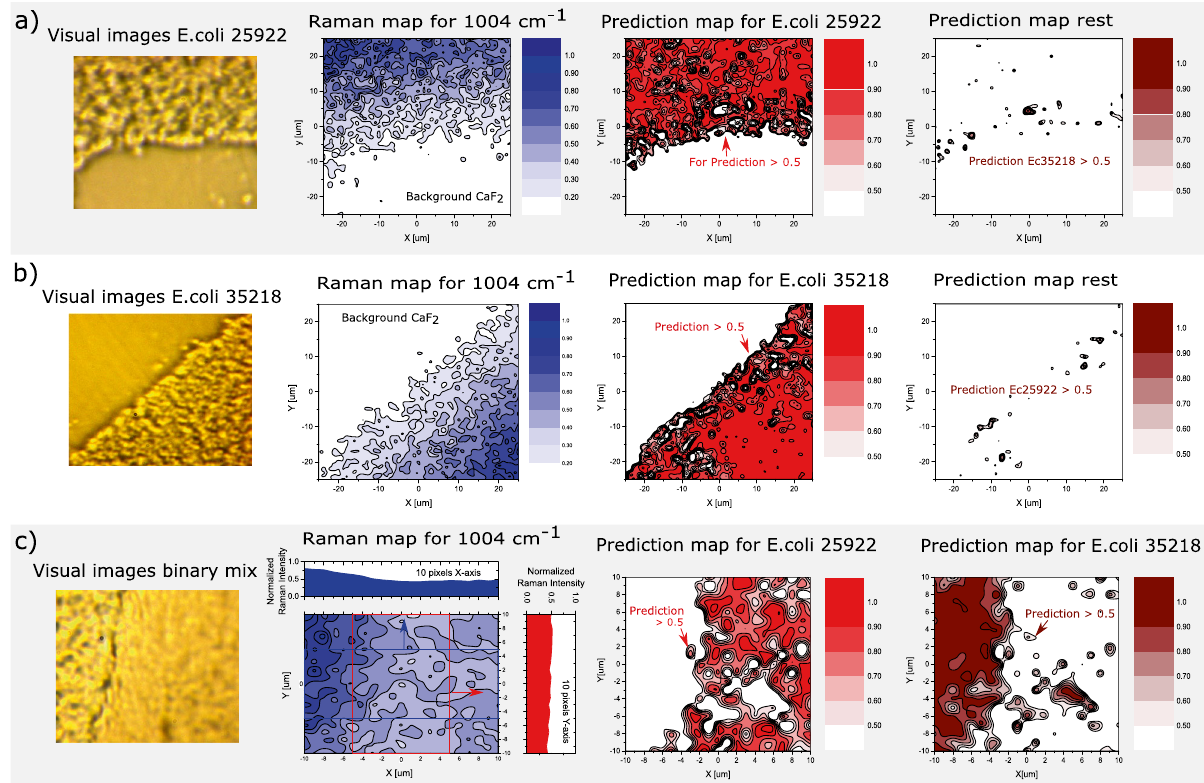
Figure 3. Raman imaging and ST identification of E. coli ATCC 25922 and E. coli ATCC 35218. The first column shows visual images of the measurement areas, and illustrates bacterial depths ranging from single- to multiple layers (4–6 µ m thick). Raman maps are shown in the second column for a Raman shift of 1004 cm assigned to the ring breathing mode vibrations of l-Phe, and finally ST prediction maps are shown in the third and fourth columns. The size of the maps are 51 µ m × 51 µ m and they each consist of 2601 Raman spectra − 1 (700–1600 cm ) with 1 µ m spacing between the points. Raman spectra are acquired with 10-times averaging of 0.5 s integration. ( a ) Raman measurements of E. coli ATCC 25922. The overall prediction rate (density surface coverage) is 49.1% for E. coli ATCC 25922, 10.4% for E. coli ATCC 35218 and 40.2% for CaF 2 background. For the rest of the bacteria/classes the total prediction rate sums to 0.3%. The prediction map to the right shows prediction for the rest of the classes plotted for >0.5, where only E. coli ATCC 35218 has values higher than 0.5. ( b ) Measurements of E. coli ATCC 35218. The overall prediction rate is 8.0% for E. coli ATCC 25922, 49.0% for E. coli ATCC 35218 and 42.8% for background. For the rest of the bacteria/classes the prediction sums to 0.2%. Again the ST makes a few E. coli ATCC 25922 misclassifications. ( c ) Raman measurements for a binary mixture of E. coli ATCC 25922 and E. coli ATCC 35218 resulting in a prediction rate (surface coverage) of 48.8% and 51.2%, respectively. The ST does in this case not make any misclassifications. All prediction of other bacteria than the two E. coli is zero. For all three acquired maps the ST prediction maps agrees very well with the Raman map and the visual